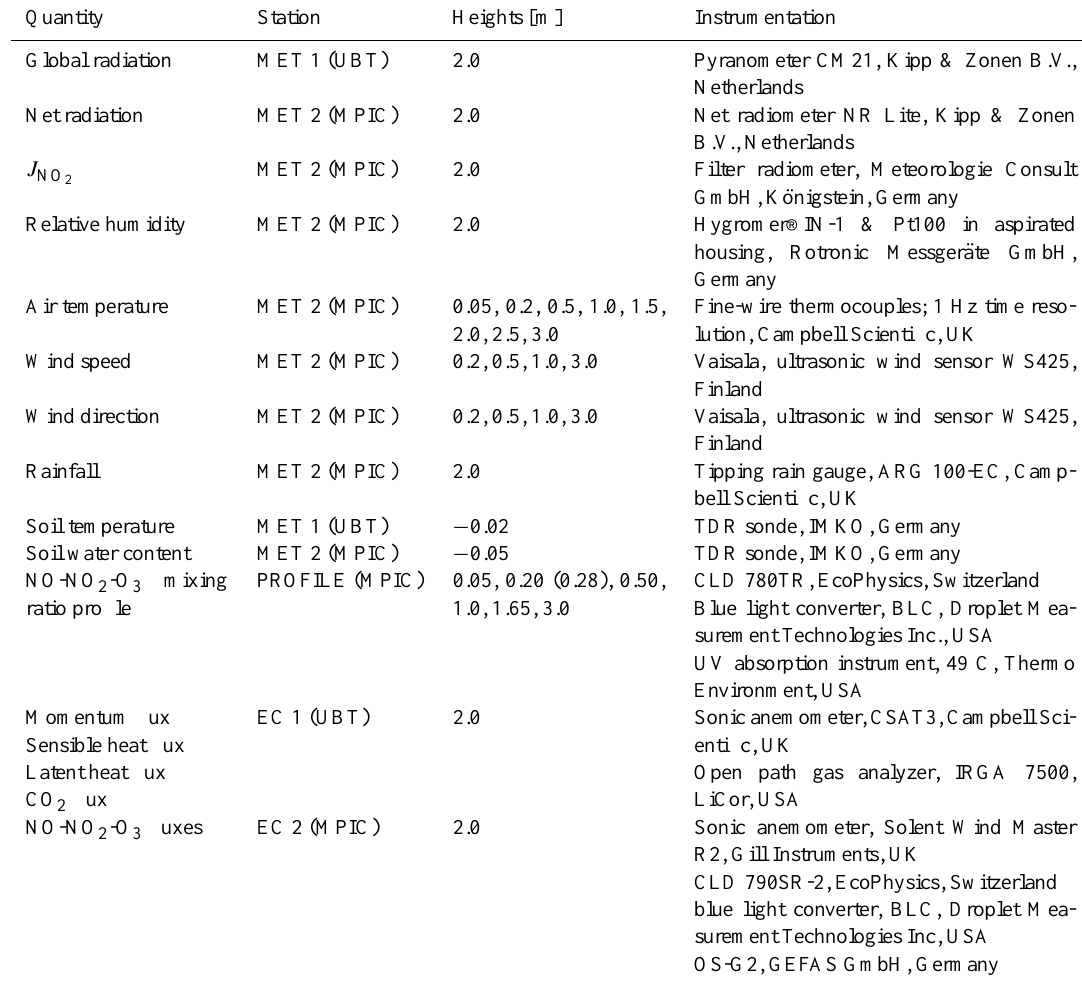
Table 1. Overview of stations and instrumentation used during the SALSA experiment.